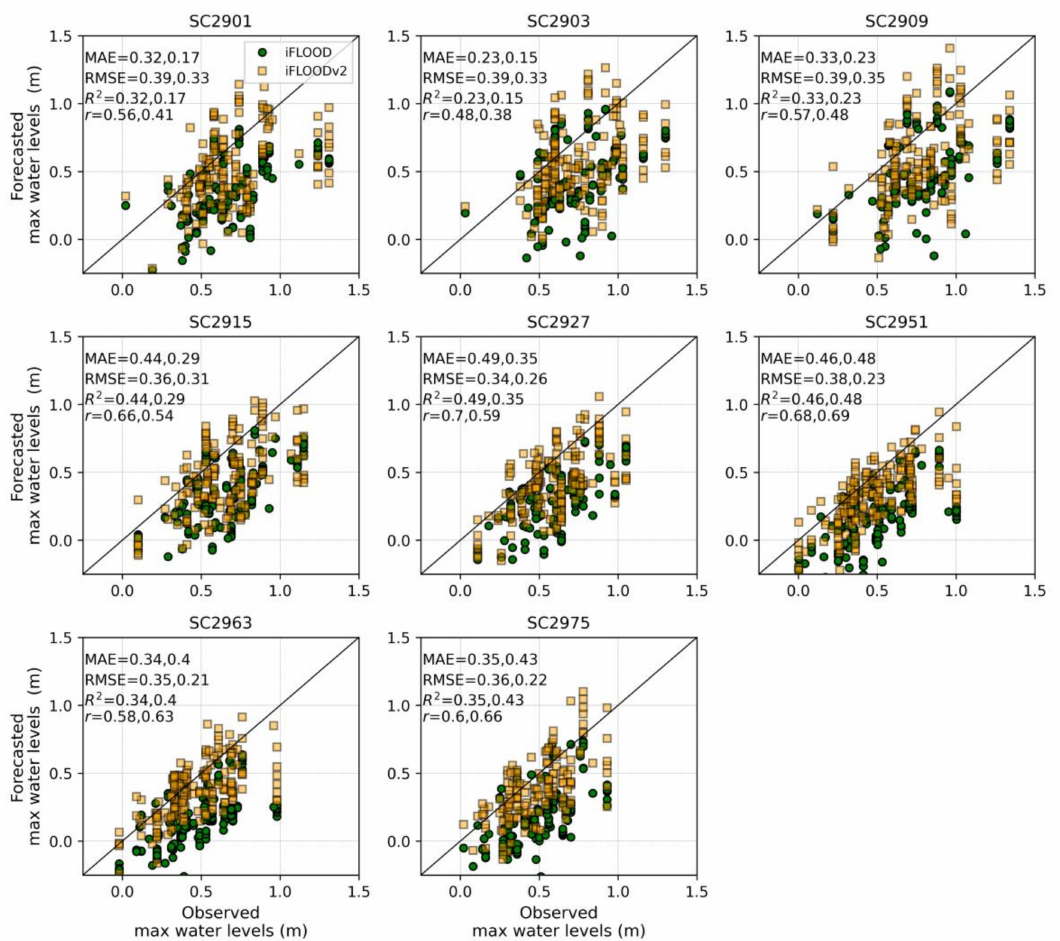
Figure 5. Scatter plots of predicted peaks of total water levels vs. observed peaks under daily weather conditions from 26 April to 31 August 2020.